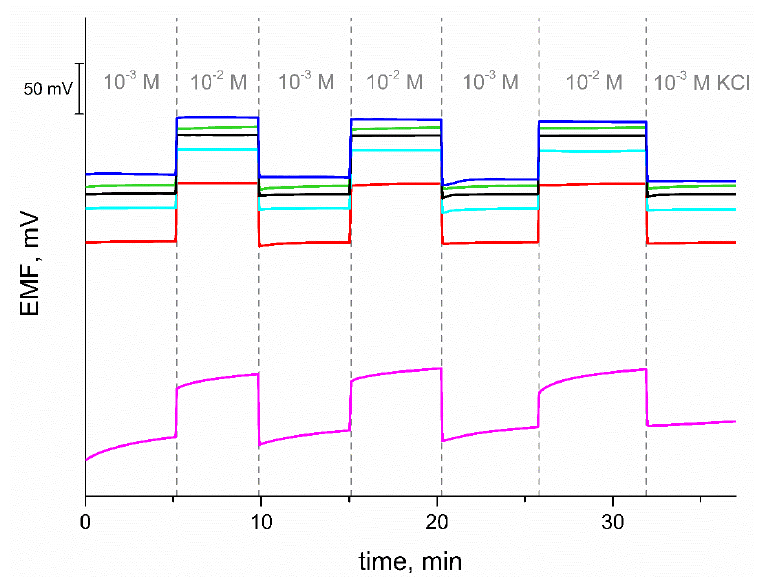
Figure 5. The reversibility test of the GC/eCNF/K + -ISM (blue), GC/eCNF-Co/K + -ISM (cyan), GC/eCNF/CNT[HD]-Co/K + -ISM (green), GC/eCNF/CNT[HD]-NiCo/K + -ISM (black), GC/eCNF/CNT[LD]-NiCo/K + -ISM (red) and coated disc electrode (magenta) recorded in KCl solutions.